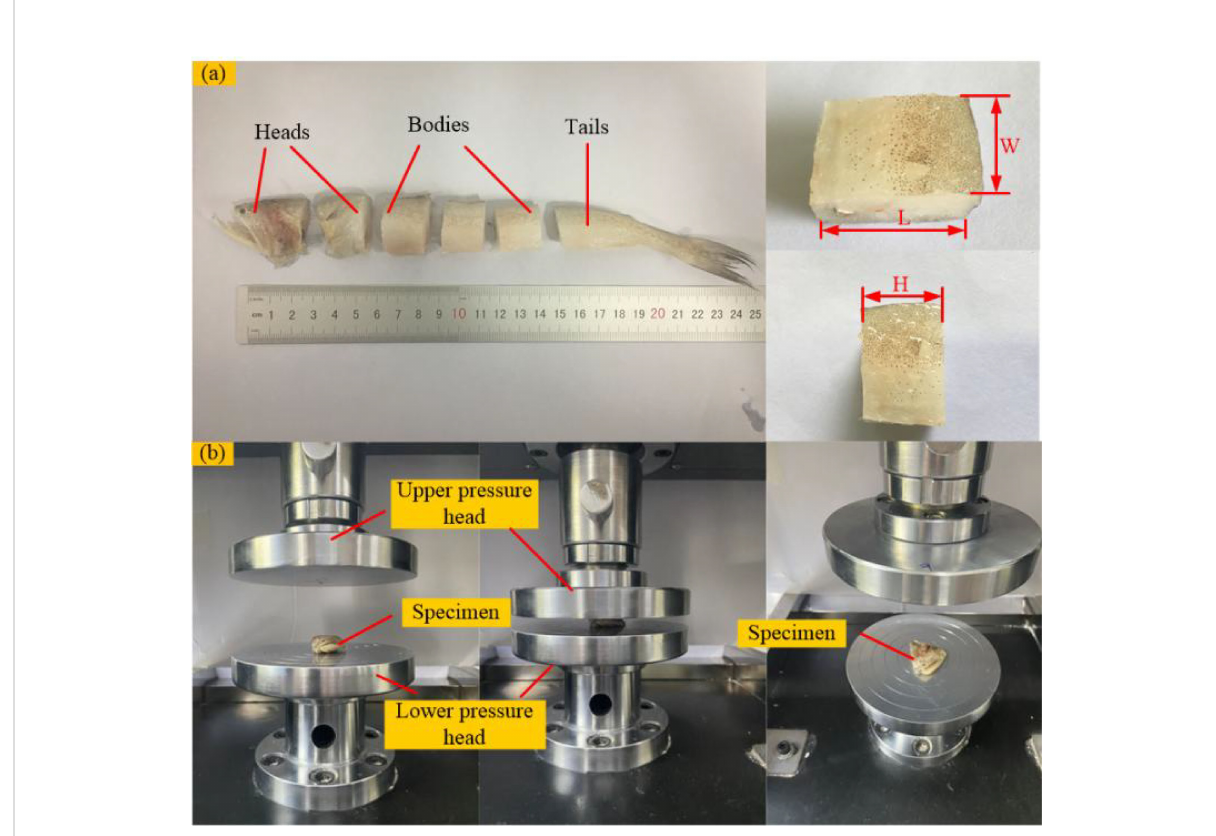
FIGURE 5 Quasi-static compression test (A) preparation of test samples of Harpadon nehereus; (B) quasi-static compression test of Harpadon